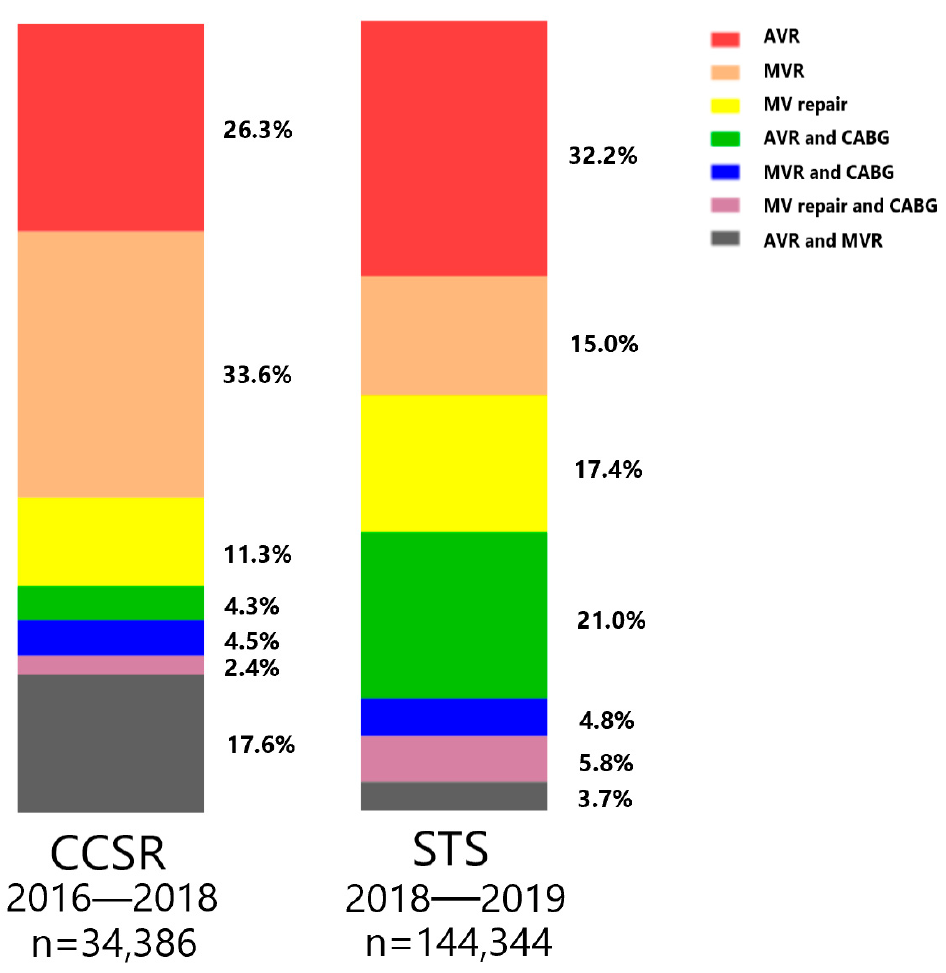
Figure 1. Proportions of the seven most commonly performed VHD surgeries. CCSR: Chinese Cardiac Surgery Registry; STS: Society of Thoracic Surgeons; AVR: aortic valve replacement; MVR: mitral valve replacement; CABG: coronary artery bypass grafting.